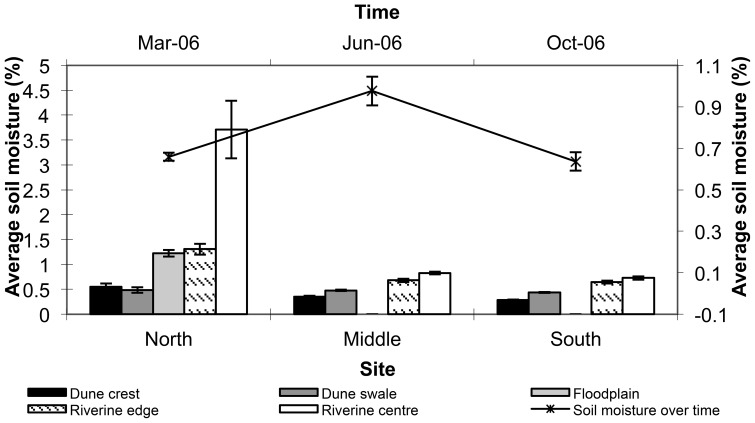
Mean (± s.e.) soil moisture (%) in five habitats at the northern, middle and southern study sitesalong the Field River, Simpson Desert, Queensland (left axis) and over time (right axis) from March 2006 to October 2006.